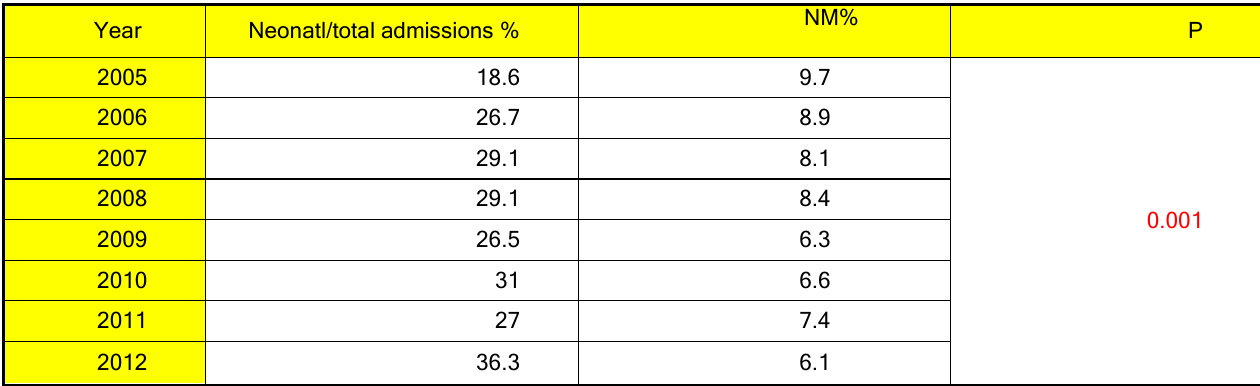
Table3 show total Correlation Coefficient r **and its p value of neonatal admission and case fatality rate and neonatal mortality % between 2005-2012. The analyses shows negative correlation of NMR and CFR over time versus positive correlation with total neonatal admission rate (